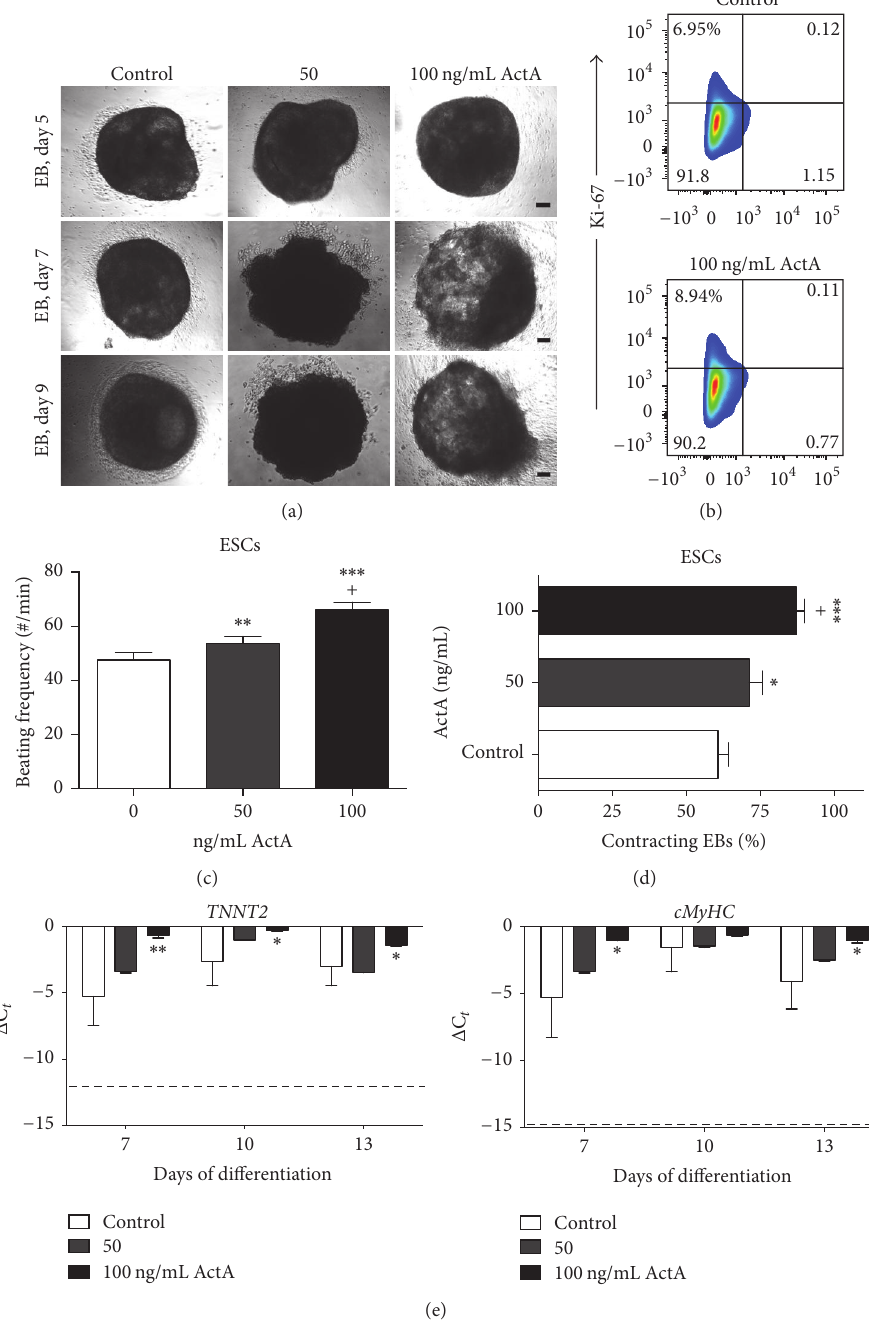
Figure 3: ActA increased human ESC-CM differentiation efficiency. High doses of 50 and 100ng/mL ActA promoted CM differentiation. (a) Brightfield images of EB morphology at days 5, 7, and 9 of differentiation of ActA treatment conditions (50 and 100 ng/mL) compared to the untreated cells (0 ng/mL ActA). (b) Proliferation was assessed using Ki-67, showing that 6.95% of the control cells and 8.94% of the ActA treated cells were in a proliferative stage. Flow cytometry analysis is a representative example of three independent experiments. (c) Quantification of contracting rate (beating frequency EBs per minute) and (d) percentage of contracting EBs at day 10 of differentiation. Efficiency is expressed as percentage of wells containing beating EBs to the total number of wells. (e) Gene expression analyses of late-stage CM genes ( TNNT2, cMyHC ) during 13 days of differentiation. Dashed lines show basal expression levels of undifferentiated ESCs. Each data point is represented as Δ C 𝑡 , normalized for the housekeeping genes GAPDH , HPRT , and RPL13a. Data are representative of three independent experimentsandexpressedasmean ± SEM.Significantdifferencesareindicatedas 𝑃 < 0.05 : ∗ versuscontroland+versus50 ng/mL; 𝑃 < 0.01 : ∗∗ versus control; 𝑃 < 0.001 : ∗∗∗ versus control. Scale bar = 100 𝜇